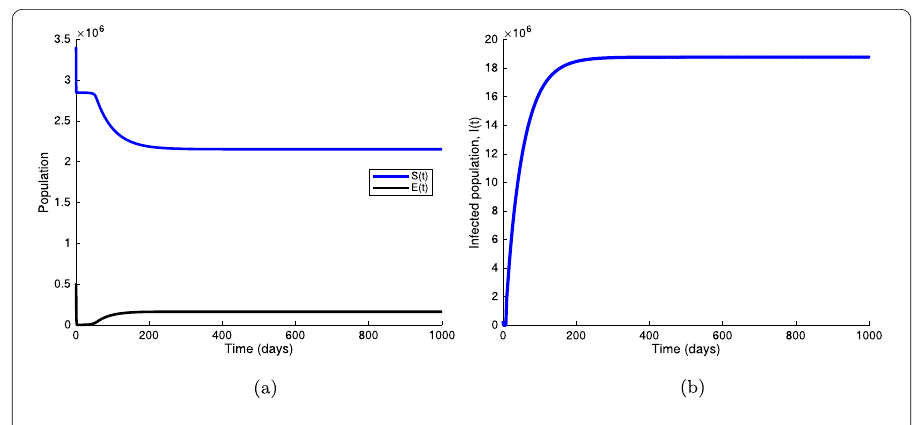
Figure 3 The dynamics of model system (1) when R E = 1.231 > 1 for the susceptible and educated populations ( a ) and the infected population ( b ) based on parameter values in Table 1